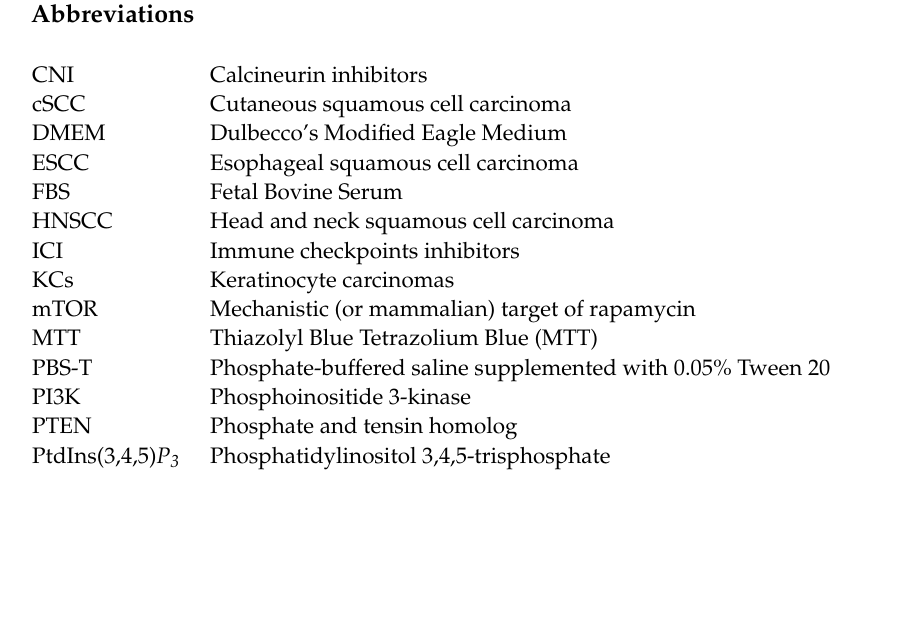
keratinocytes and cSCC cells and validation of loading control. Figure S2: Expression of p110 γ and p110 δ in cSCC cells. Figure S3: The PI3K/Akt/mTOR pathway regulates growth and viability of cSCC cell lines. Figure S4: Vehicle control does not affect number and viability of cells. Figure S5: BYL719 reduces numbers and viability of keratinocytes more potently than GSK2636771. Figure S6: BYL719 more potently than GSK2636771 reduces numbers and viability of IC8 and Met1 but not IC1 cells. Figure S7: BYL719 inhibits Akt phosphorylation in Met1 cells. Figure S8: BYL719 inhibits Akt activation in IC8 cells. Figure S9: BYL719 inhibits Akt activation in Met1 cells. Figure S10: BYL719 but not GSK2636771 inhibits Akt activation in IC8 cells. Figure S11: A66 inhibits Akt activation in IC8 and Met1 cells. Figure S12: BYL719 inhibits Akt activation in IC8 and Met1 cells. Figure S13: BYL719 inhibits Akt activation in T11 cells. Figure S14: BYL719 inhibits Akt activation in IC1